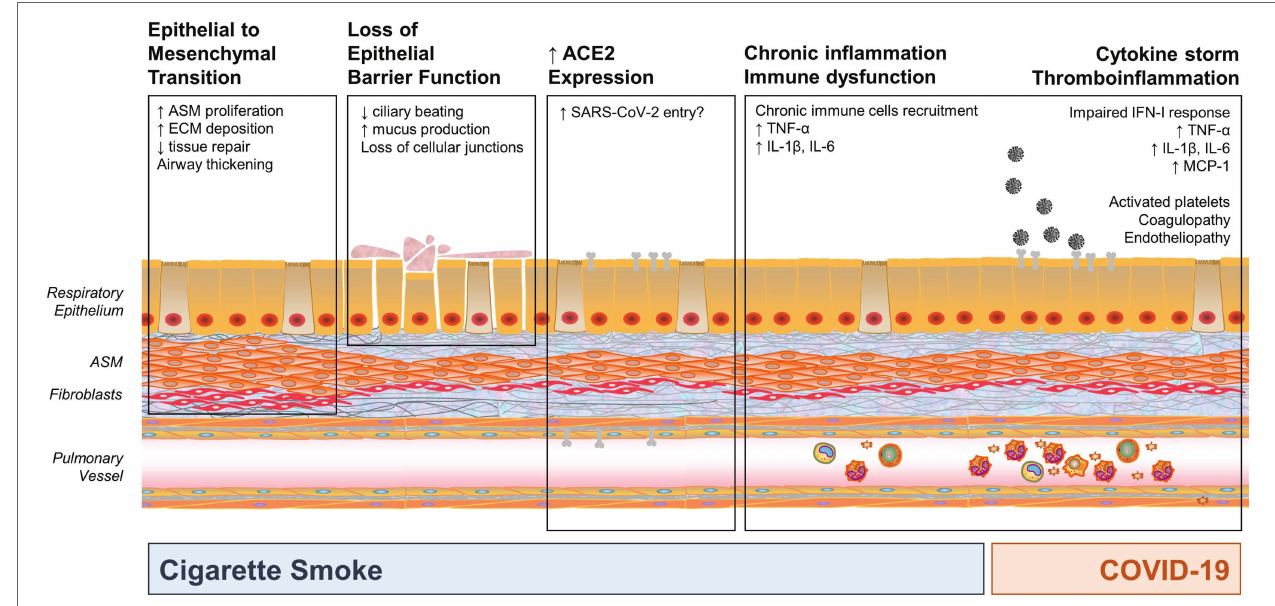
FIGURE 1 | Mechanisms by which cigarette smoke exposure (CSE) and coronavirus disease 2019 (COVID-19) may impact the developing and pediatric airway, highlighting potential areas of synergy. CSE results in three main impacts: epithelial to mesenchymal transformation, loss of epithelial barrier function (which may increase susceptibility to infection), and chronic inflammation and immune dysfunction. In addition, smoking increases angiotensin-converting enzyme 2 (ACE2) expression, which is a key entry point for severe acute respiratory syndrome coronavirus 2 (SARS-CoV-2), thus potentially increasing susceptibility to infection. COVID-19 also results in significant inflammation and cytokine response. Synergy between CSE and SARS-CoV-2 may occur in activation of pro-inflammatory mediators, such as TNF- α , IL-1 β , IL-6, and other mediators that may result in cytokine storm, pronounced inflammatory state, and immune dysfunction. (ASM, airway smooth muscle; ECM, extracellular